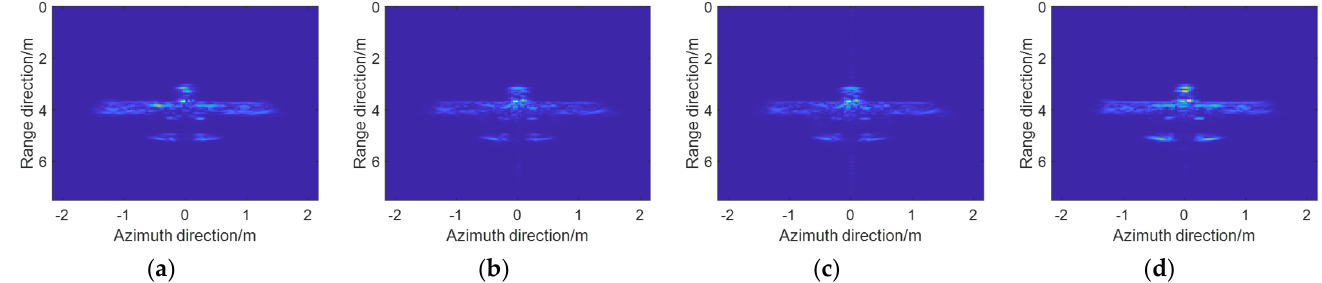
Figure 11. UAV imaging results using RD algorithm: ( a ) HH polarization channel; ( b ) HV polarization channel; ( c ) VH polarization channel; ( d ) VV polarization channel.